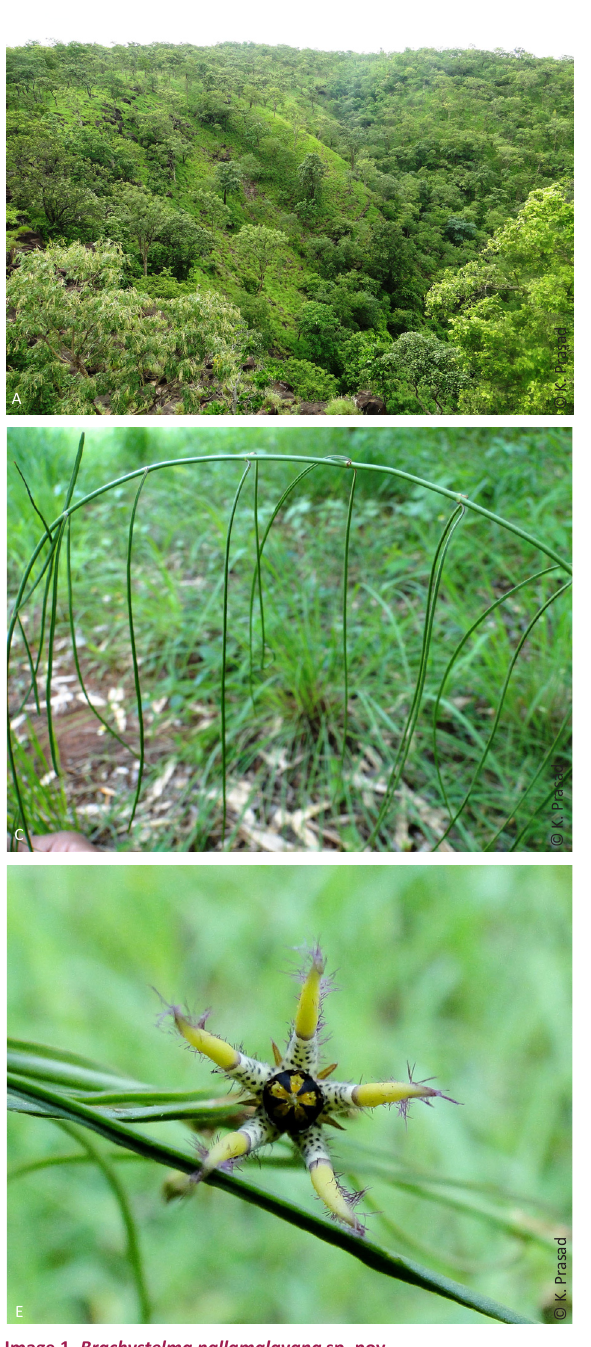
the back of the anthers, exceeding and hooded on the style apex. Pollinia waxy, yellow, globose, ca. 200µm long, margins pellucid at apex, attached by light brown tubular caudicles to a red-coloured corpuscle. Style apex pentangular. Follicles not